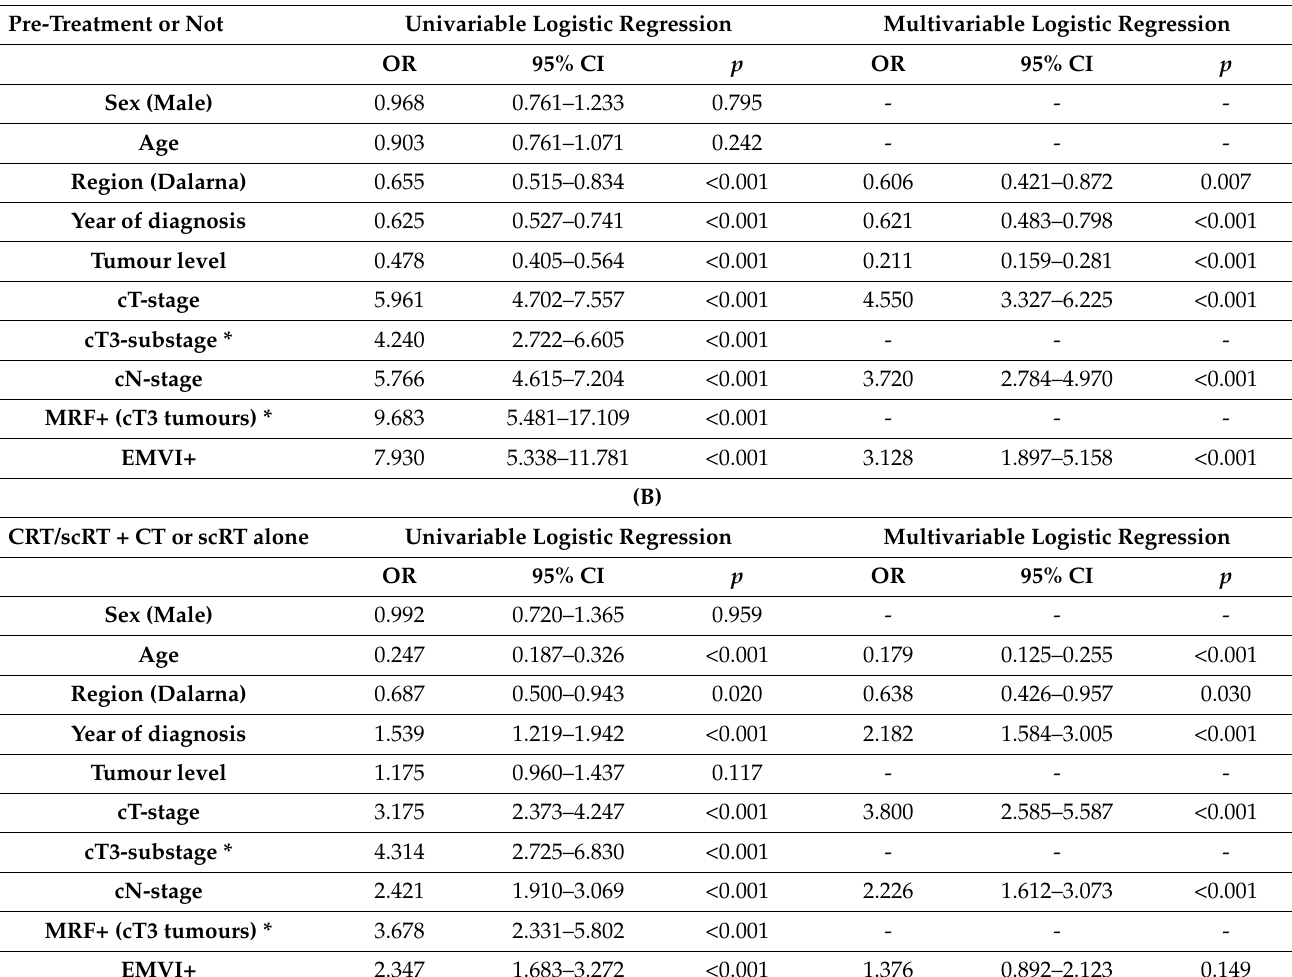
Table 3. ( A ) Univariable and multivariable logistic regression for patients that had preoperative treatment (short-course radiotherapy (scRT) or chemoradiotherapy/scRT + chemotherapy) ( n = 630) compared to patients that had no preoperative treatment ( n = 475). ( B ) Univariable and multivariable logistic regression for patients that had chemoradiotherapy (CRT) or short-course radiotherapy(scRT) + chemotherapy (CT) ( n = 275) compared to patients that had only scRT ( n = 355).